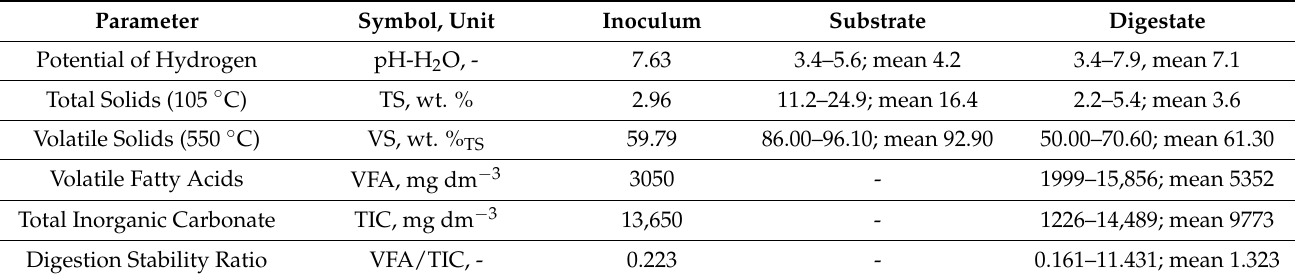
Figure 1. Apparatus diagram. 1. Rotary drum reactor. 2. Stator connected to the base. 3. Liquid batch level. 4. Port for substrate dosing and digestate sampling. 5. Biogas outlet tube. 6. Thermocouple. 7. Dissolved hydrogen sensor. 8. Two valves for sampling and return of biogas. 9. Gas flow meter. 10. Portable gas analyzer. 11. Water heated jacket. Table 1. Inoculum, Substrate, and Digestate